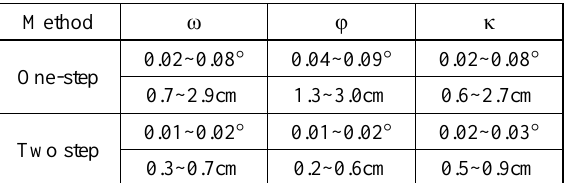
Table 2. Error ranges of boresight angles of six cameras and